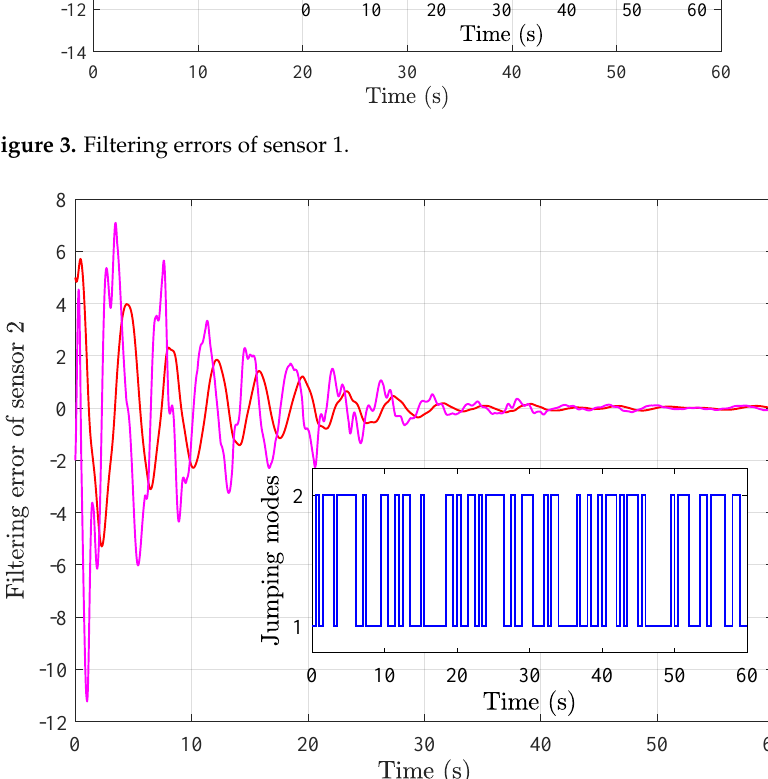
Figure 4. Filtering errors of sensor